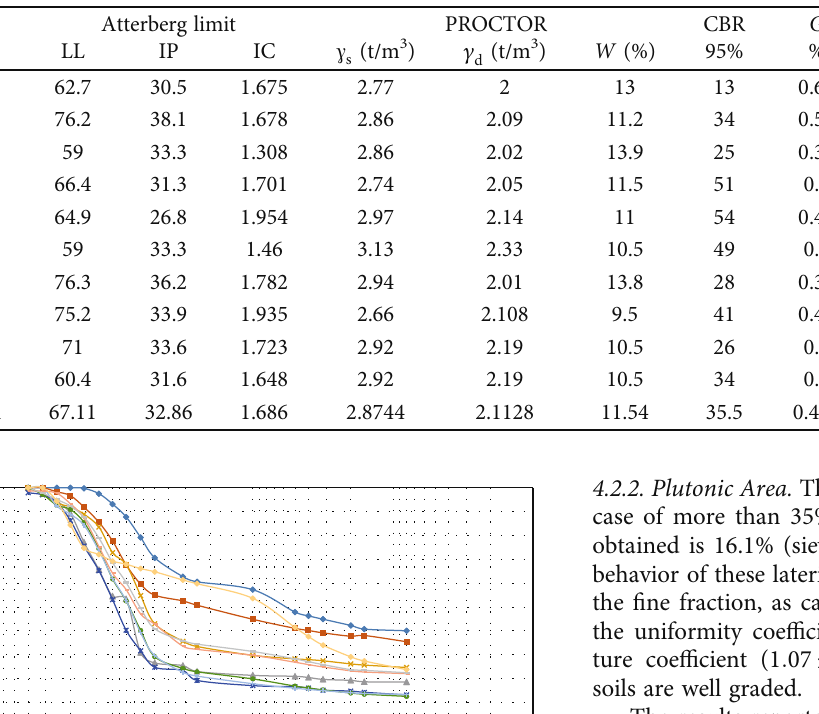
Table 6: Geotechnical results in the green belt zone.